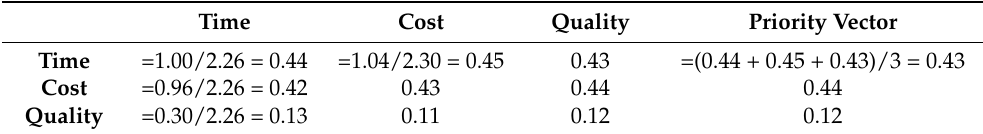
Table 8. Normalized decision matrix and priority